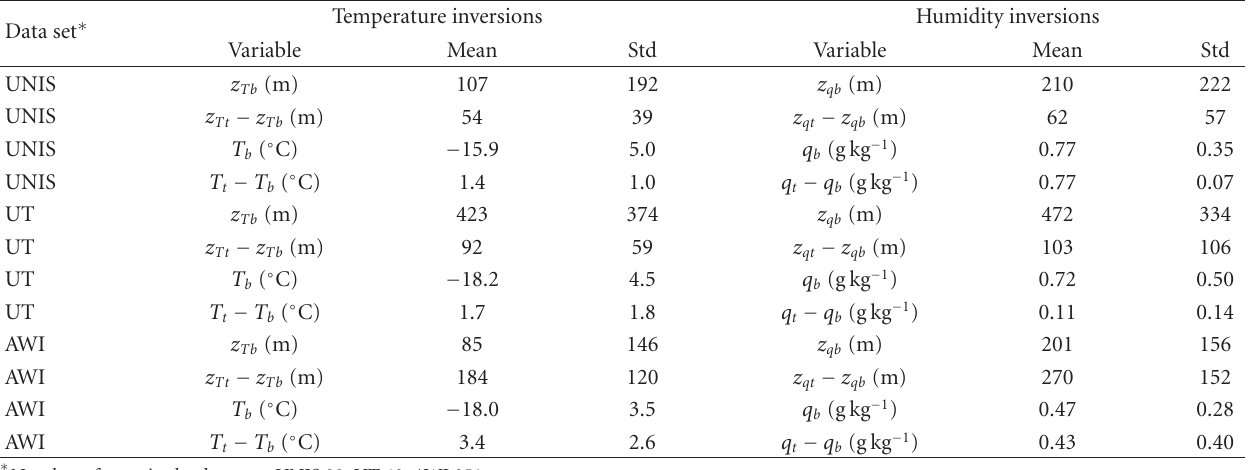
Table 3: Statistics of temperature and humidity inversions. See the text for definition of the symbols.